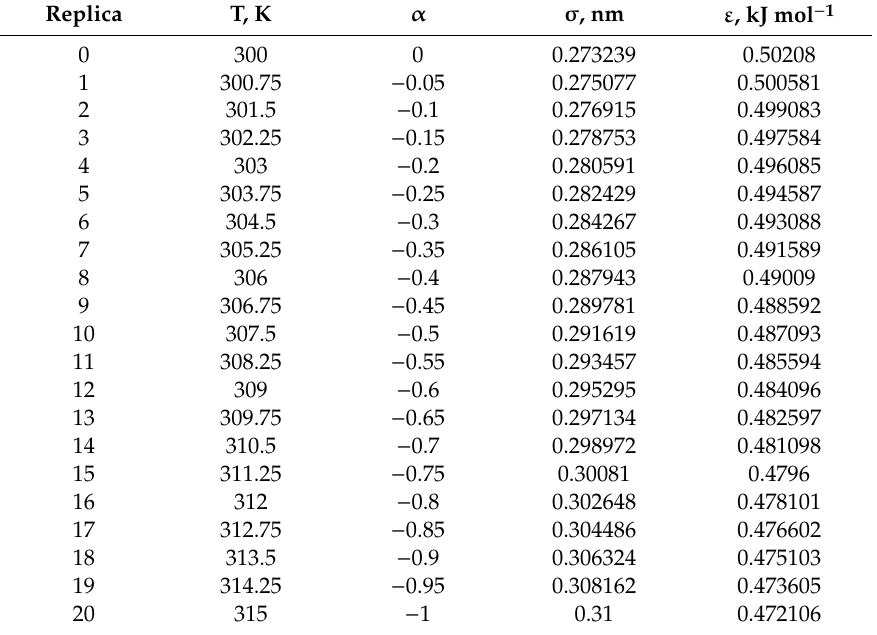
Table 2. Parameters varied in the Hamiltonian replica exchange (HRE)